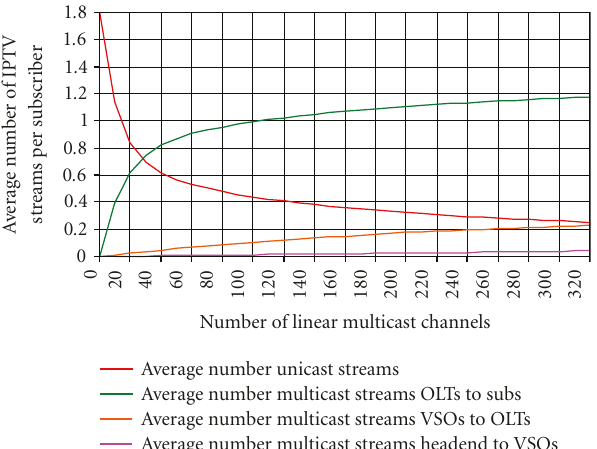
Figure 4: Unicast versus multicast bandwidth. Unicast is consid- ered to be VOD, delivered from the headend or VHO, not P2P.